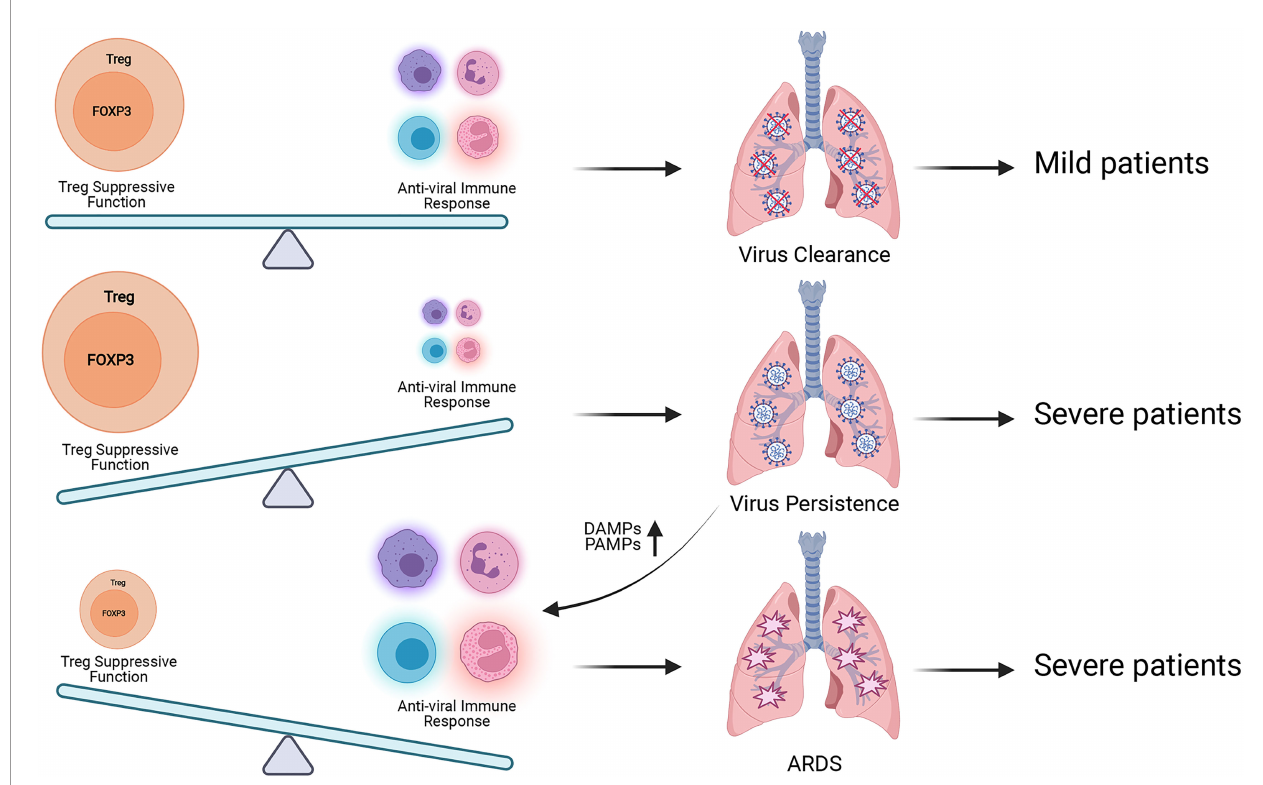
FIGURE 3 | Treg has dual roles during SARS-CoV-2 infection. The balance between Treg suppressive function for maintaining immune homeostasis and antiviral immune responses for eliminating SARS-CoV-2 is proposed to be kept well in the mild patients. When this balance is broken, patients will suffer poorer prognosis. Excessive Treg activity will result in virus persistence, more production of pro-in fl ammatory DAMPs and PAMPs and exacerbated in fl ammation. Insuf fi cient Treg activity will contribute to aggressive in fl ammatory response with cytokine storm which leads to tissue damage and ARDS. More researches are required to explore the best time for Treg-based therapy to avoid severe COVID-19